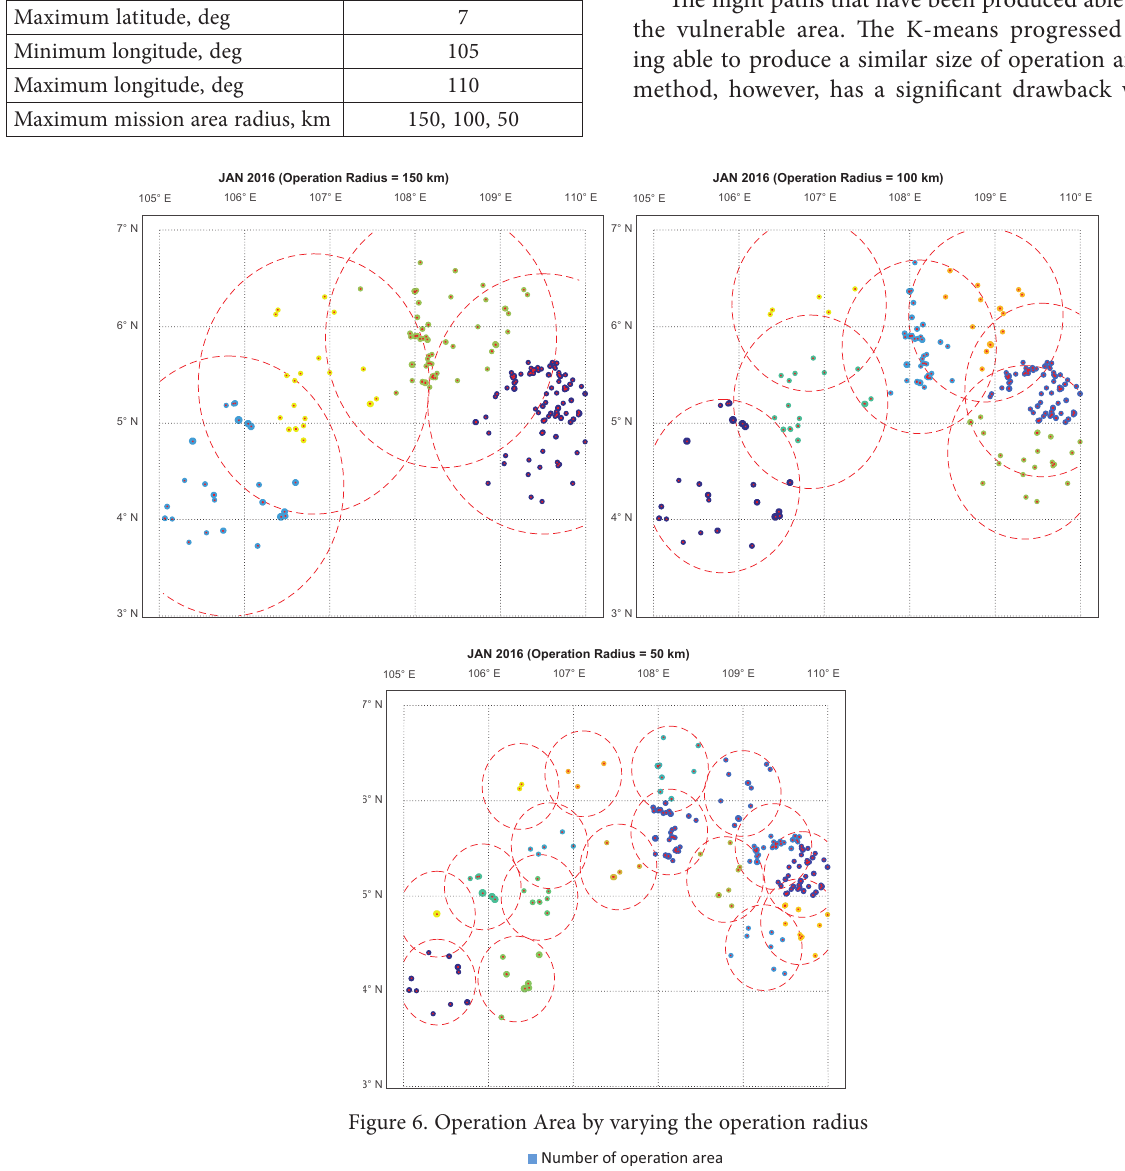
Figure 6. Operation Area by varying the operation radius